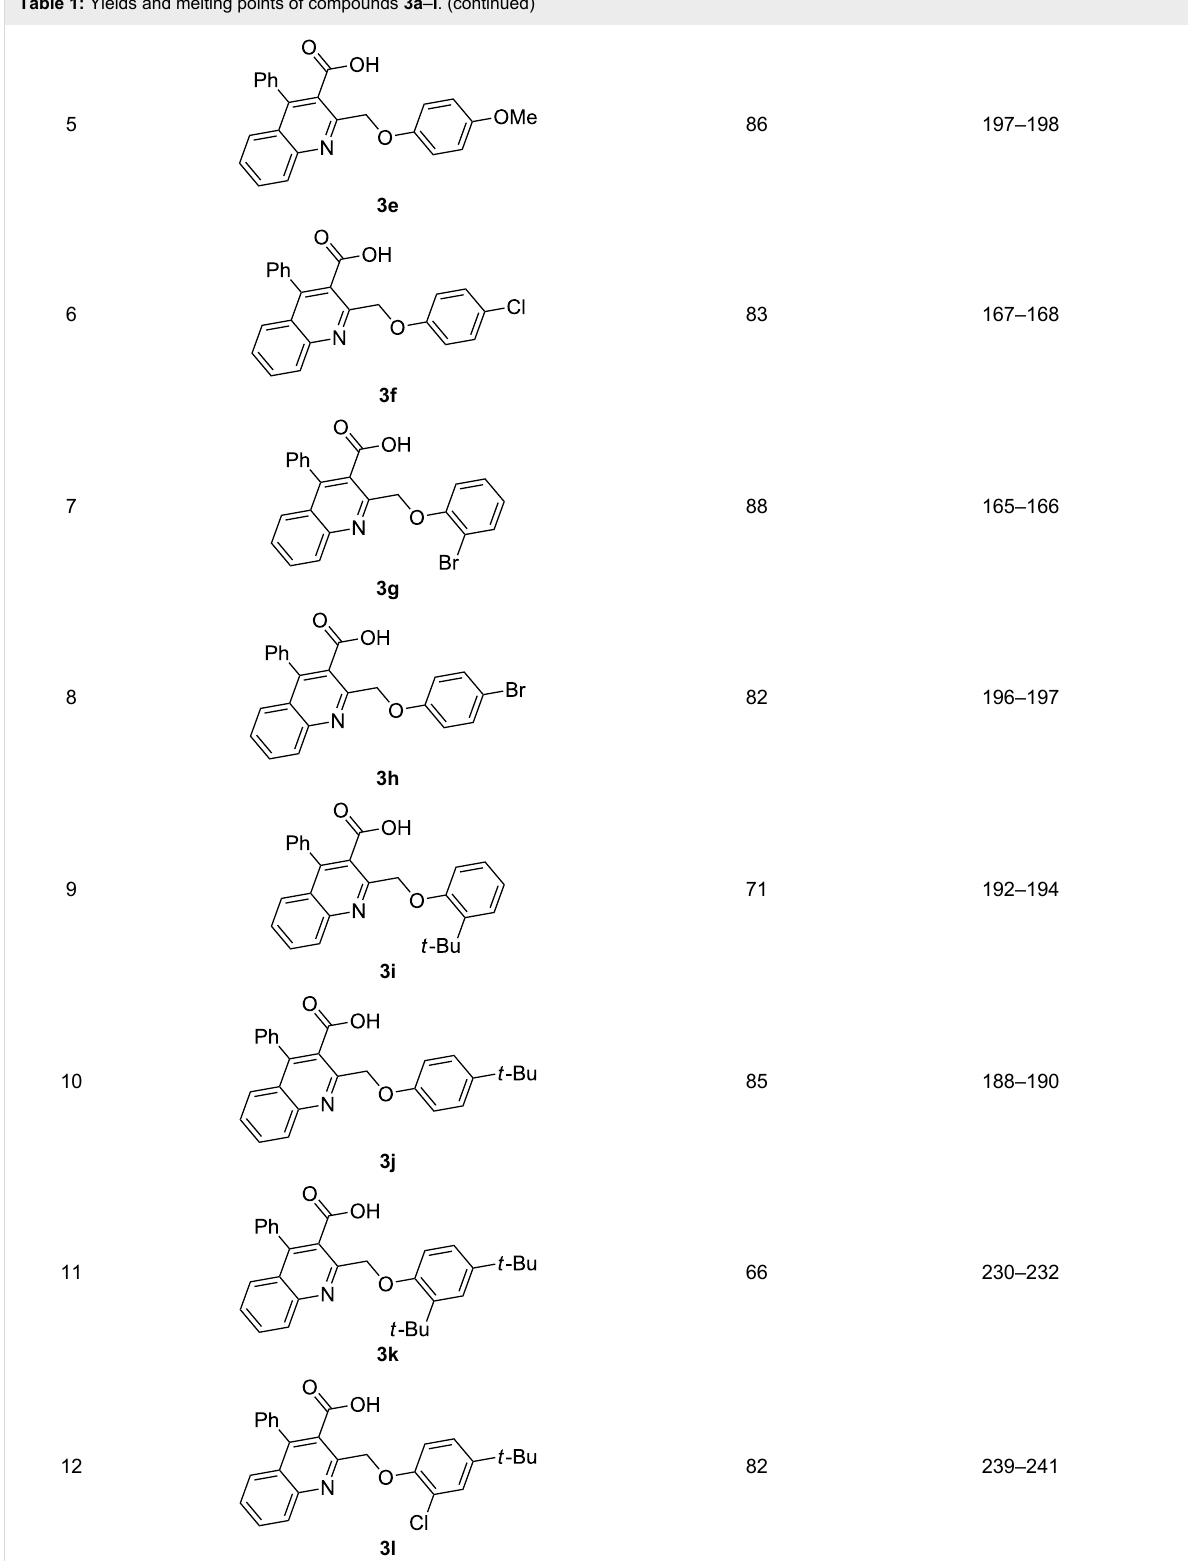
Table 1: Yields and melting points of compounds 3a – l .